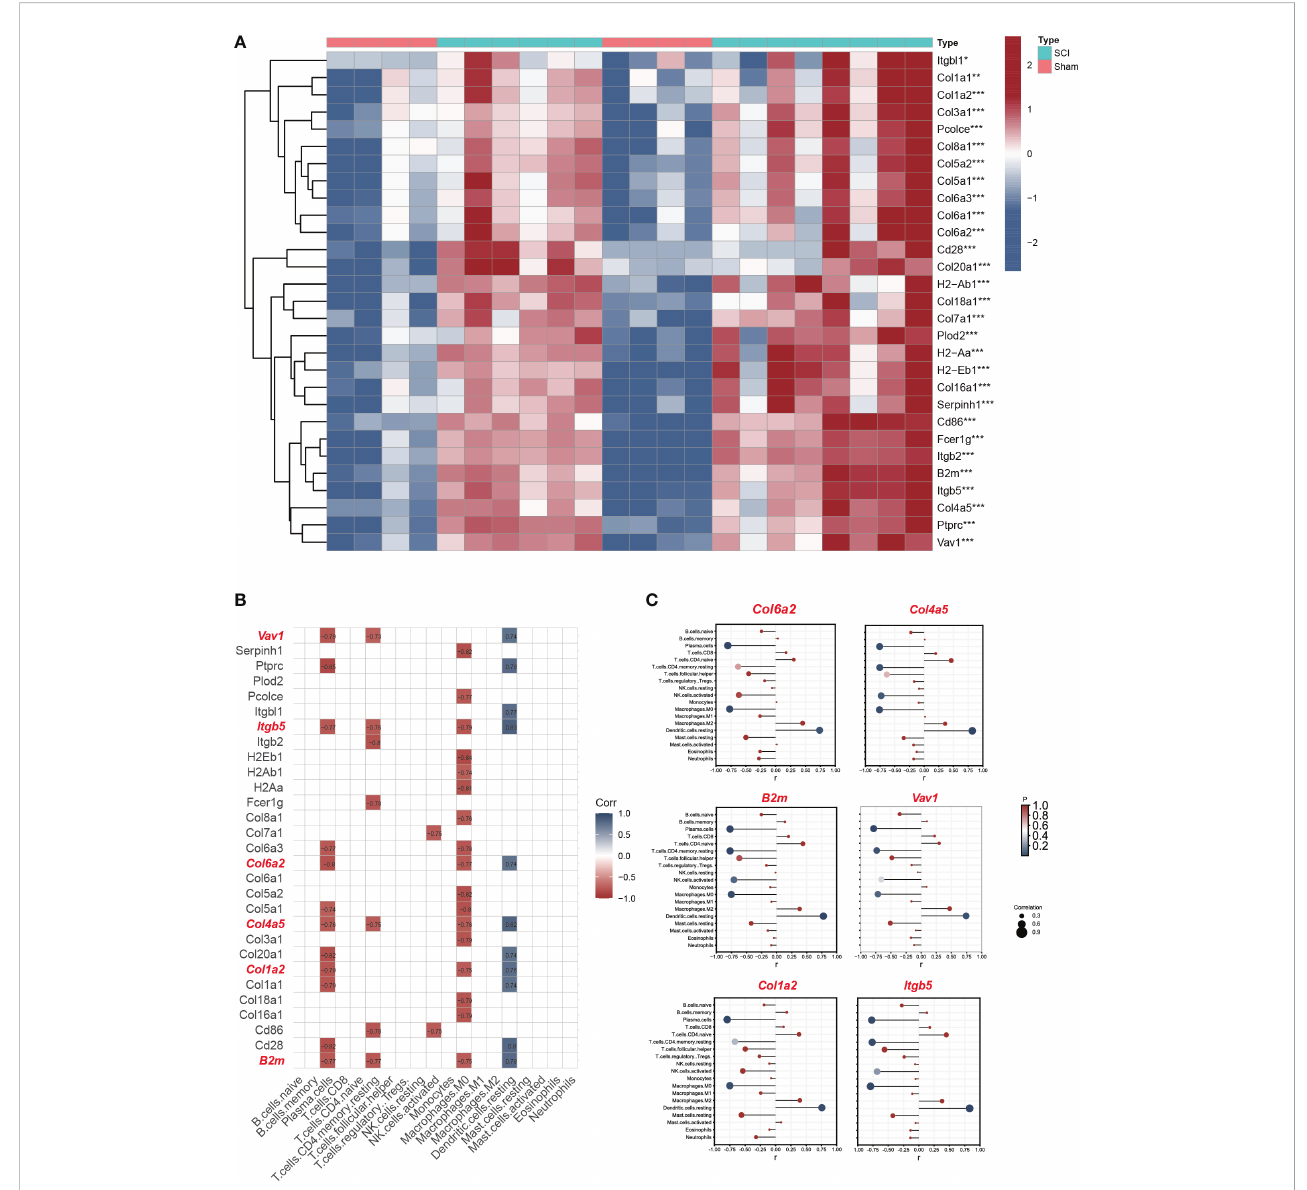
FIGURE 6 Screening immune hub genes based on bulk RNA seq datasets. (A) The expression matrix heatmap of 29 hub genes. (B) The correlation analyses between hub genes and immune characteristics between SCI and uninjured samples. The criteria for selection of key immune genes related to SCI were as follows: >2 immune cell correlation, correlation coef fi cient >0.3, and p<0.05. (C) The lollipop plot of six immune hub genes ( Vav1, Itgb5, B2m, Col1a2, Col4a5, Col6a2 ). *P < 0.05, **P < 0.01, ***P <